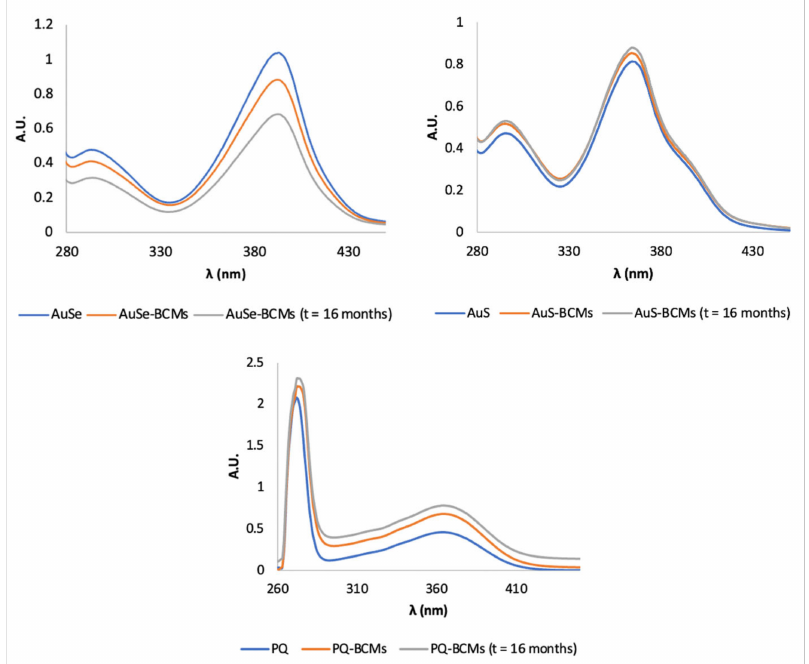
Figure 4. Comparison between the UV–Vis spectra of free AuSe, AuS, and PQ (blue lines) and the respective loaded micelles (AuSe-BCMs, AuS-BCMs, and PQ-BCMs) immediately after the preparation of the micelles (orange lines) and after 16 months (gray